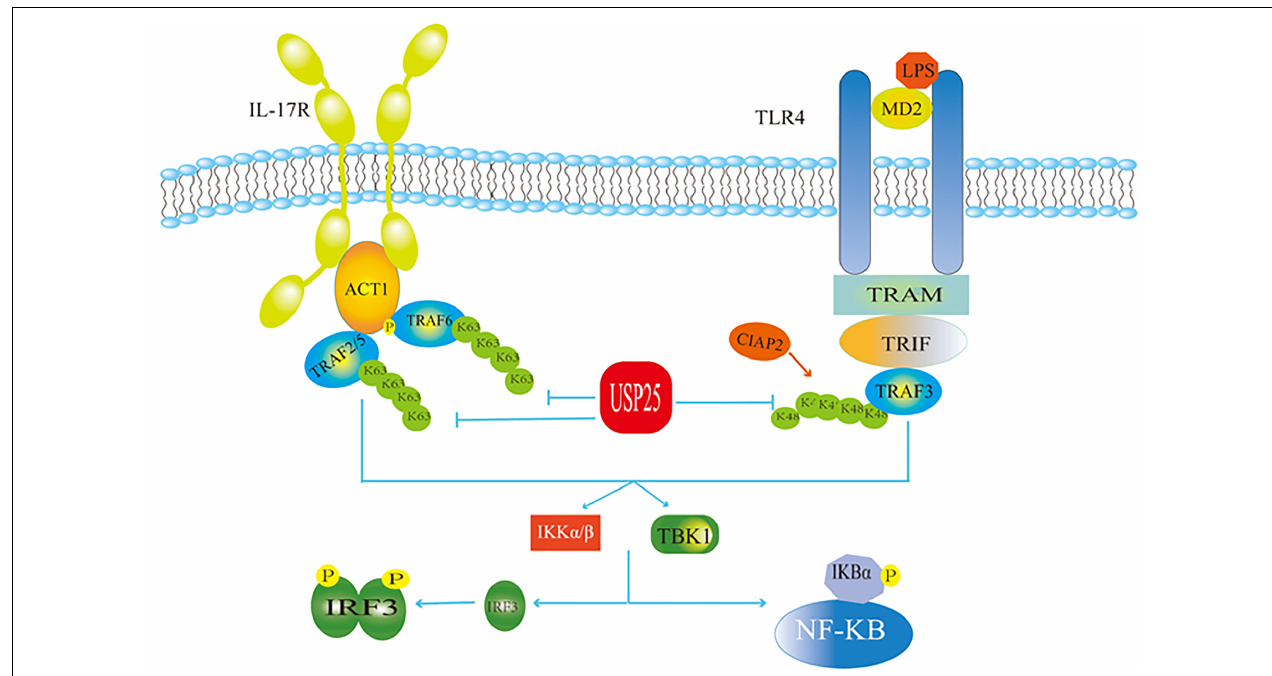
FIGURE 3 | USP25 in antiviral immunity. USP25 affects the IRF and NF- κ B pathways by acting on ubiquitination of TRAF in the IL-17R and TLR4 pathways, respectively, thereby regulating the downstream molecules.